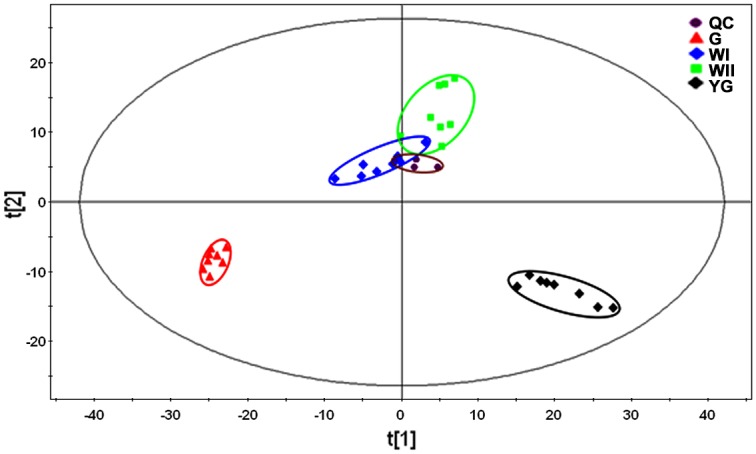
PCA was used to compare the metabolic profiles of the tea plant at three albescent stages (YG, WI and WII) and the G stage.Score plots for principle components 1 and 2 showed high cohesion within groups and good separation among leaf groups from the three different albescent stages (YG, WI and WII) and the G stage. The sampling groups are color coded as follows: black = YG-stage leaves; blue = WI-stage leaves; green = WII-stage leaves; red = G-stage leaves; and purple = QC samples.